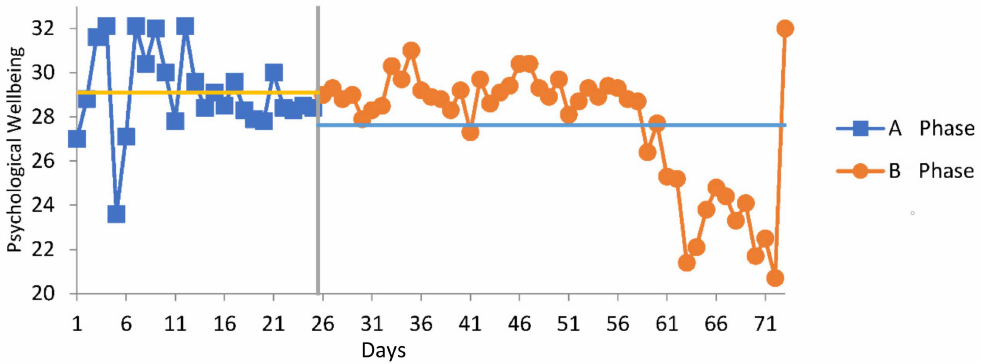
Figure 2. Psychological Wellbeing changes from phase A to B for